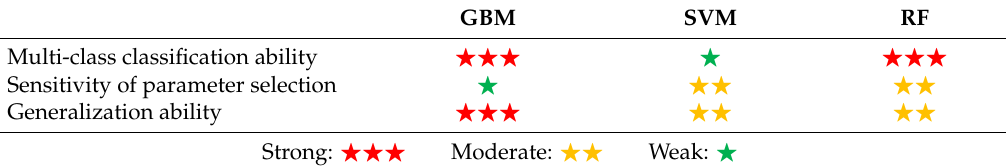
Table 6. Performance comparisons between gradient boosting machine, support vector machine and random forest. GBM SVM RF Multi-class classification ability (cid:70)(cid:70)(cid:70) (cid:70) (cid:70)(cid:70)(cid:70) Sensitivity of parameter selection (cid:70) (cid:70)(cid:70) (cid:70)(cid:70) Generalization ability (cid:70)(cid:70)(cid:70) (cid:70)(cid:70) (cid:70)(cid:70) Strong: (cid:70)(cid:70)(cid:70) Moderate: (cid:70)(cid:70) Weak: